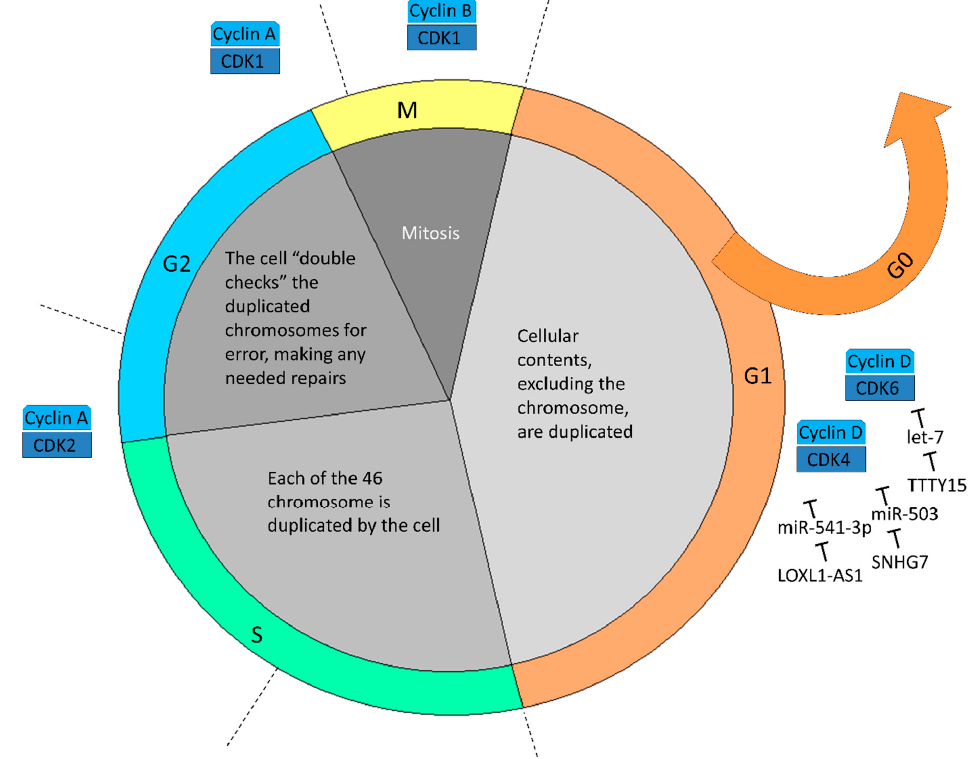
Figure 2. The mechanisms of actions for lncRNAs and miRNAs in cell cycle progression in castration-resistant prostate cancer cells. Most of the miRNAs in contemporary pieces of evidence function in the canonical checkpoint that prevents G1 phase cells from entering the S phase. Cancer cells overwhelm pRb growth suppression through inactivation of pRb by Cyclin D-CDK4/6. MiRNAs inhibit Cyclin D-CDK4/6, but their inhibitory ability is abolished by lncRNAs indicated above. 5.4. Cytokines and Other Transmembrane Proteins Integrins are transmembrane proteins that facilitate cell-to-cell and cell-to-extracellu- lar matrix adhesion [81]. CD51, otherwise named integrin subunit alpha V (ITGAV), is a member of the integrin alpha chain family [82]. CD51 inhibited E-cadherin expression and activated transforming growth factor-beta (TGF- β ), a well-known multifunctional cyto- kine [83]. Mechanical tension of the cells alongside binding of the large latent TGF- β com- plex exposes the active TGF- β through the latency-associated peptide (LAP) opening. By binding to TGF- β receptor on neighboring cells, activated TGF- β acts on the surrounding stromal, immune, endothelial, and smooth muscle cells. It results in immunosuppression and angiogenesis, finally enhancing the invasiveness of cancer cells [84]. LncRNA SNHG17 level is elevated in CRPC cell lines and tissues and is positively correlated with CD51 expression. Mechanically, SNHG17 directly bound with miR-144 and inhibited miR-144 targeting downstream CD51. Herein, SNHG17 enhanced cell proliferation and invasion in vitro and promoted tumor growth and metastasis in vivo [67]. 6. The Interplay between lncRNA and miRNA/Epigenetic Regulators in NEPC 6.1. General Introduction of NEPC NEPC is a rare subtype of prostate cancer. From 2004 to 2013, only 0.06% of patients were classified to de novo NEPC among patients diagnosed with prostate cancer in the